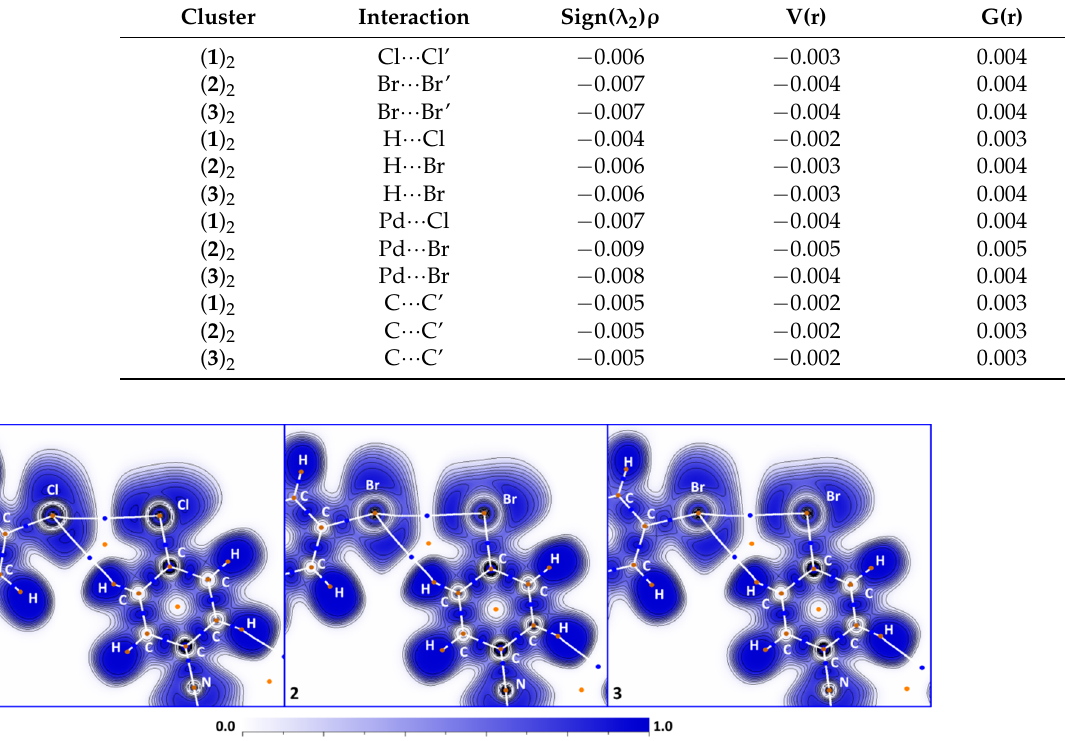
Table 3. Characteristic parameters of C–H ∙∙∙ X–C hydrogen bonds in 1 – 3 . Structure